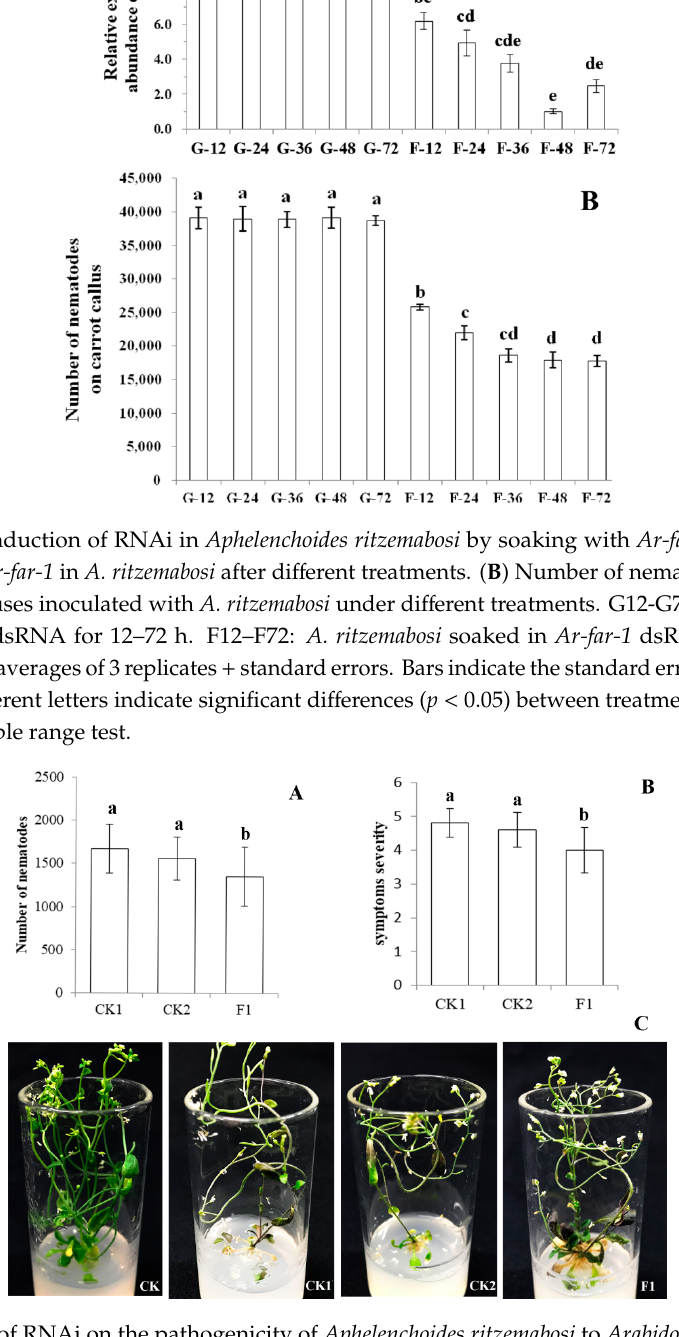
Figure 8. Effect of RNAi on the pathogenicity of Aphelenchoides ritzemabosi to Arabidopsis thaliana. ( A ) Reproduction numbers of A. ritzemabosi treated with Ar-far-1 dsRNA on leaves of the A. thaliana Col-0 ecotype. ( B ) Effects of A. ritzemabosi on symptom severity in A. thaliana . ( C ) Symptoms in A. thaliana caused by A. ritzemabosi . CK: blank control; CK1, CK2, F1: A. ritzemabosi soaked in ddH 2 O, egfp dsRNA and Ar-far-1 dsRNA, respectively, for 48 h. Bars indicate standard errors of the means ( n = 3), and the same letters indicate no significant difference ( p < 0.05) between treatments according to Duncan’s multiple range test.